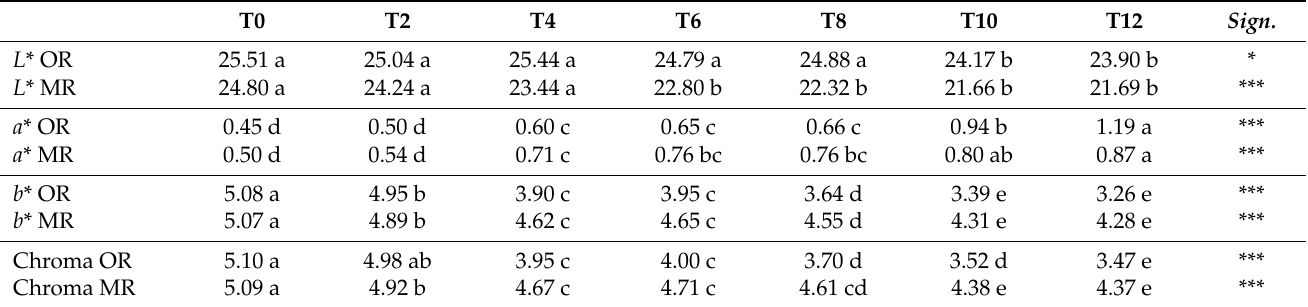
Table 5. Colour of fat samples from Cantuccini biscuits made from the original recipe (OR; 50% cow’s butter/50% margarine) and modified recipe (MR; 70% EVOO/30% cow’s butter). One-way ANOVA, means ± SD (of six replicates) in the same row followed by a different letter are significantly